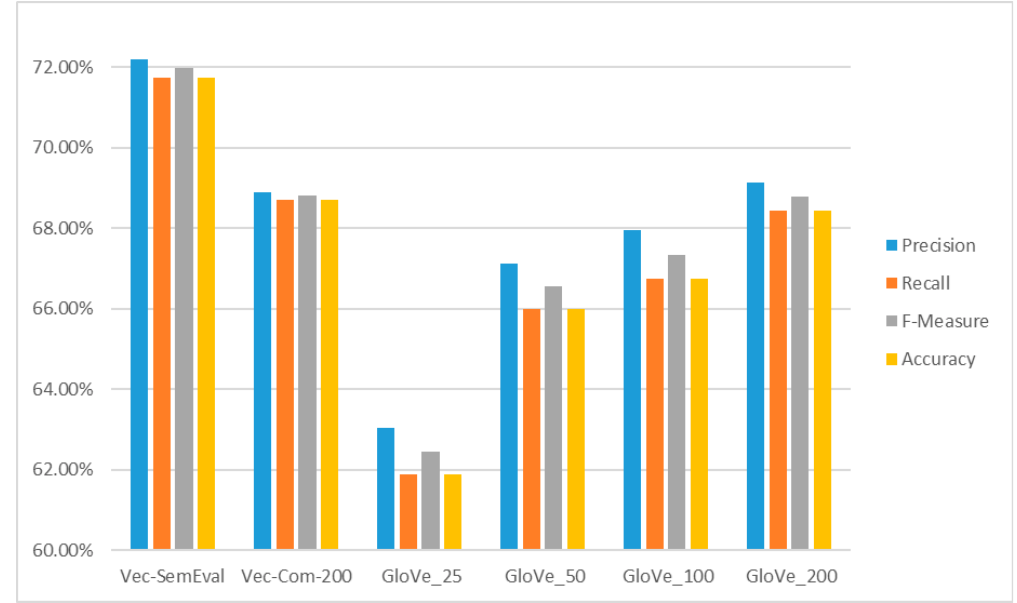
Figure 4. The performance of sentiment classification using Twitter-based pretrained GloVe embedding